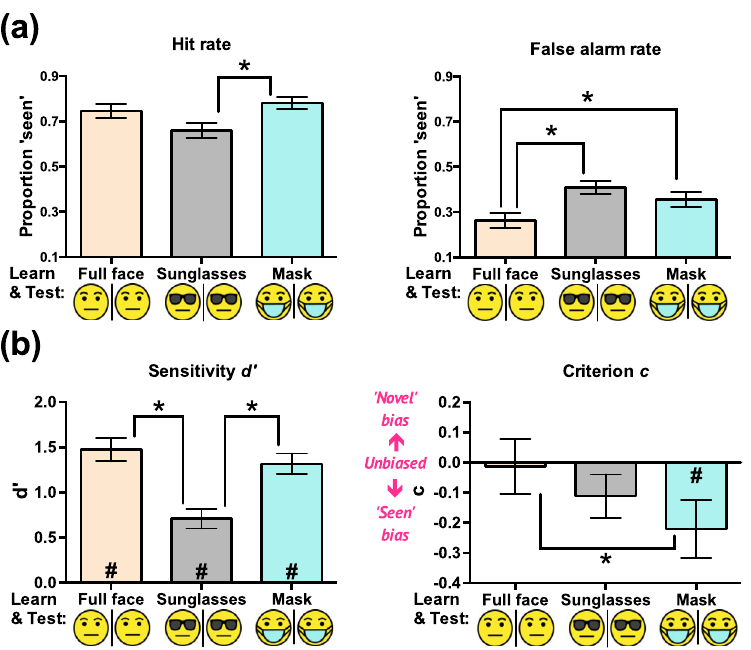
Figure 2. Experiment 1 results: ( a ) Hit rates and false alarm rates, and ( b ) sensitivities d’ and criteria c (indicating response biases) across the three conditions. All error bars represent ± 1 SEM. The asterisks (*) indicate significant pairwise differences between conditions. The hash signs (#) in ( b ) represent d’ or c significantly different from zero in the indicated conditions. The unmarked bars and comparisons were not statistically significant. The significance level was set at